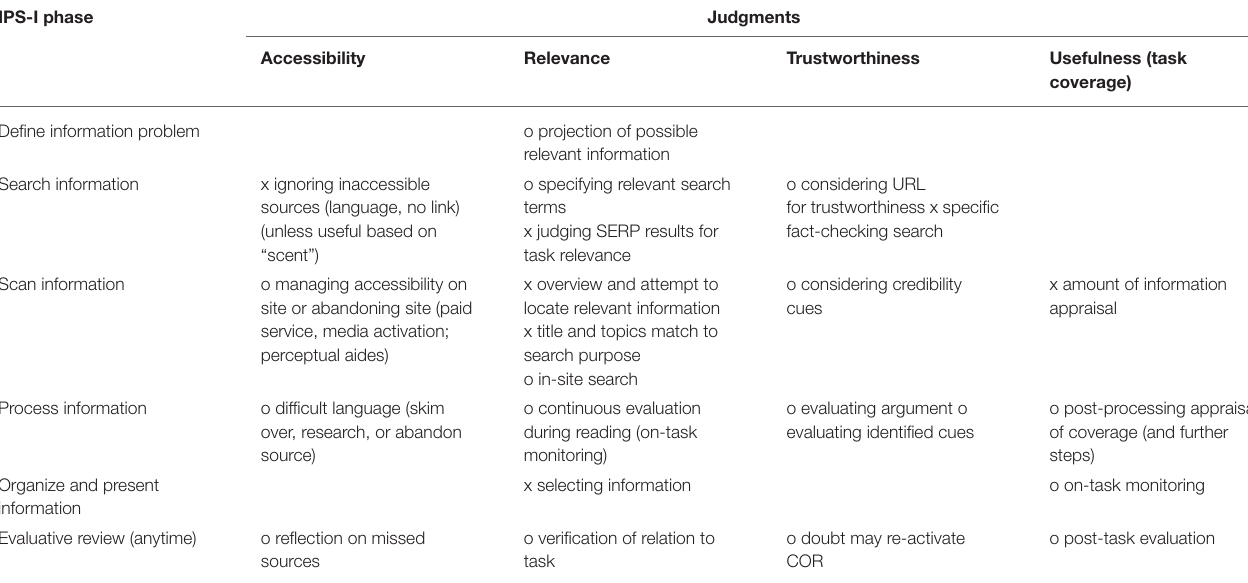
TABLE 2 | Possible and necessary processes contributing to quality criterion judgments, with web content considered, attributed to IPS-I phase (on evaluative review, see CORA-MCA and